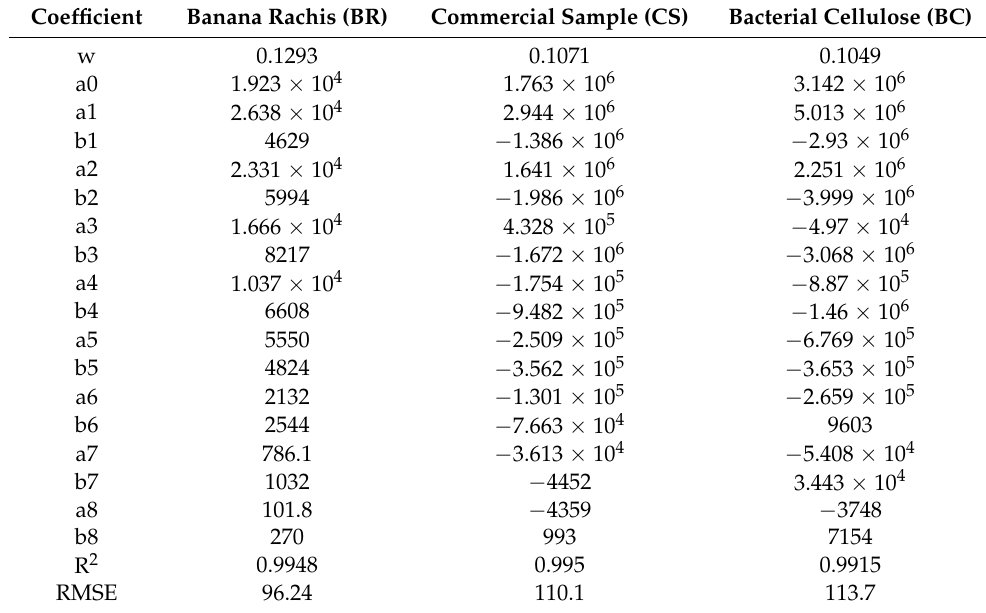
Table 3. Fourier-series coefficients found in the fitting conducted in